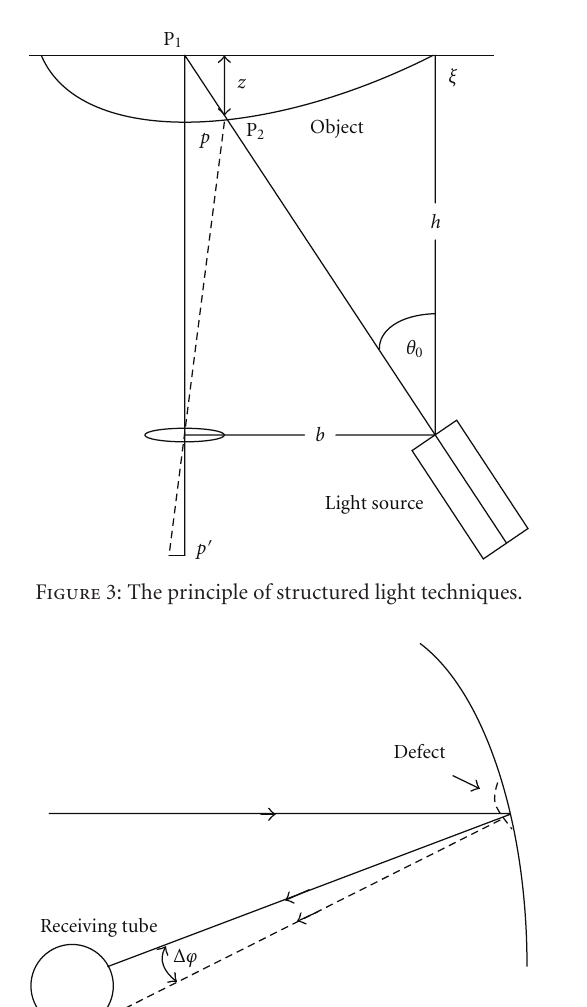
the measurement point. But in case of a mirror, the detected spot shift depends on the slope of the surface. The foremost parameter to be measured is the slope of the local defect, because it combines high and extension of the local defect.